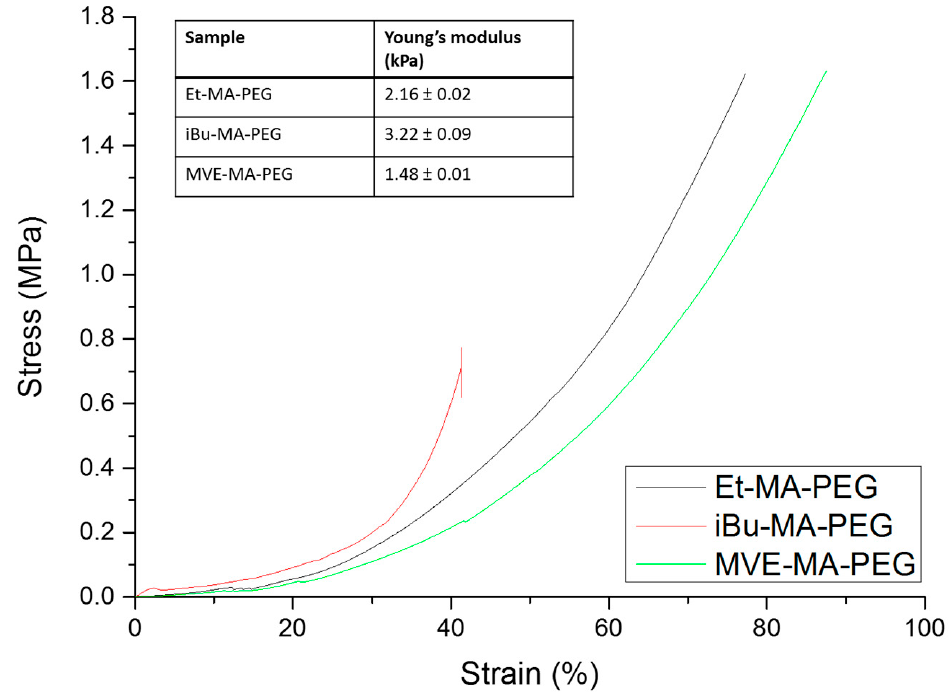
Figure 5. Compression stress/strain test for the synthesized hydrogels: Et-MA–PEG; iBu-MA–PEG; and MVE-MA–PEG.